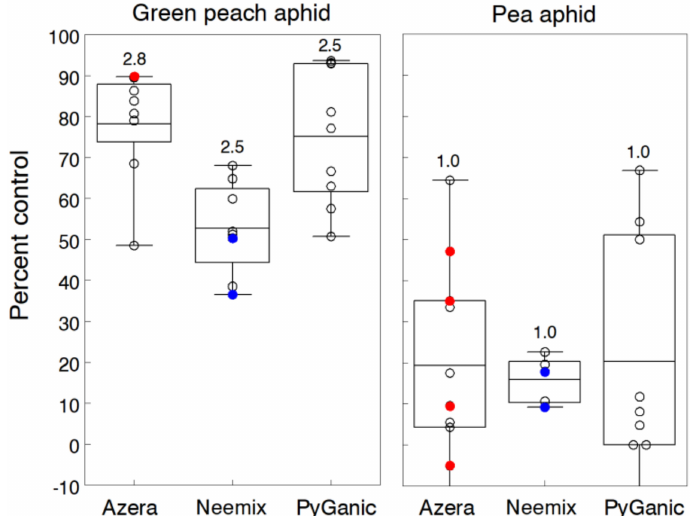
Figure 2. Percent control of green peach aphid and pea aphid with weekly applications of Azera, Neemix and PyGanic relative to the untreated control. Mean data for each insecticide are given for five and seven trials on cole crops and alfalfa, respectively. Box-whisker plots show the 25% and 75% percentile range of percent control data and the horizontal line in each box is the overall mean control e ffi cacy. Number above each plot indicates the average number of weekly applications. Application rates of Azera, Neemix, PyGanic and Entrust were 2.34 L / h, 1169 mL / h, 2.34 L / h and 71.2 g a.i. / h respectively, except for individual trial data in blue and red indicating lower and higher rates, respectively. There were no significant di ff erences among treatments for each